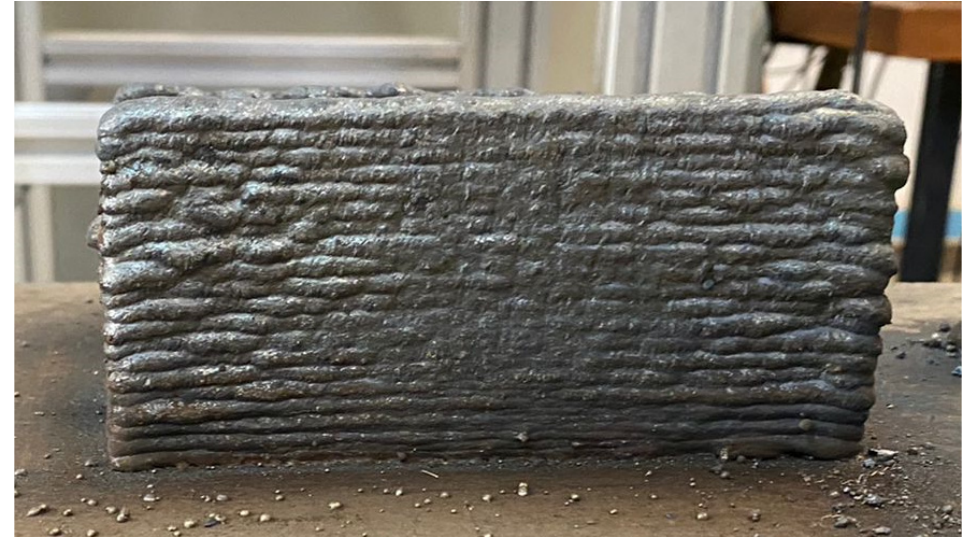
Figure 10. Multi-layered structure from WAAM process on SS 316L substrate.